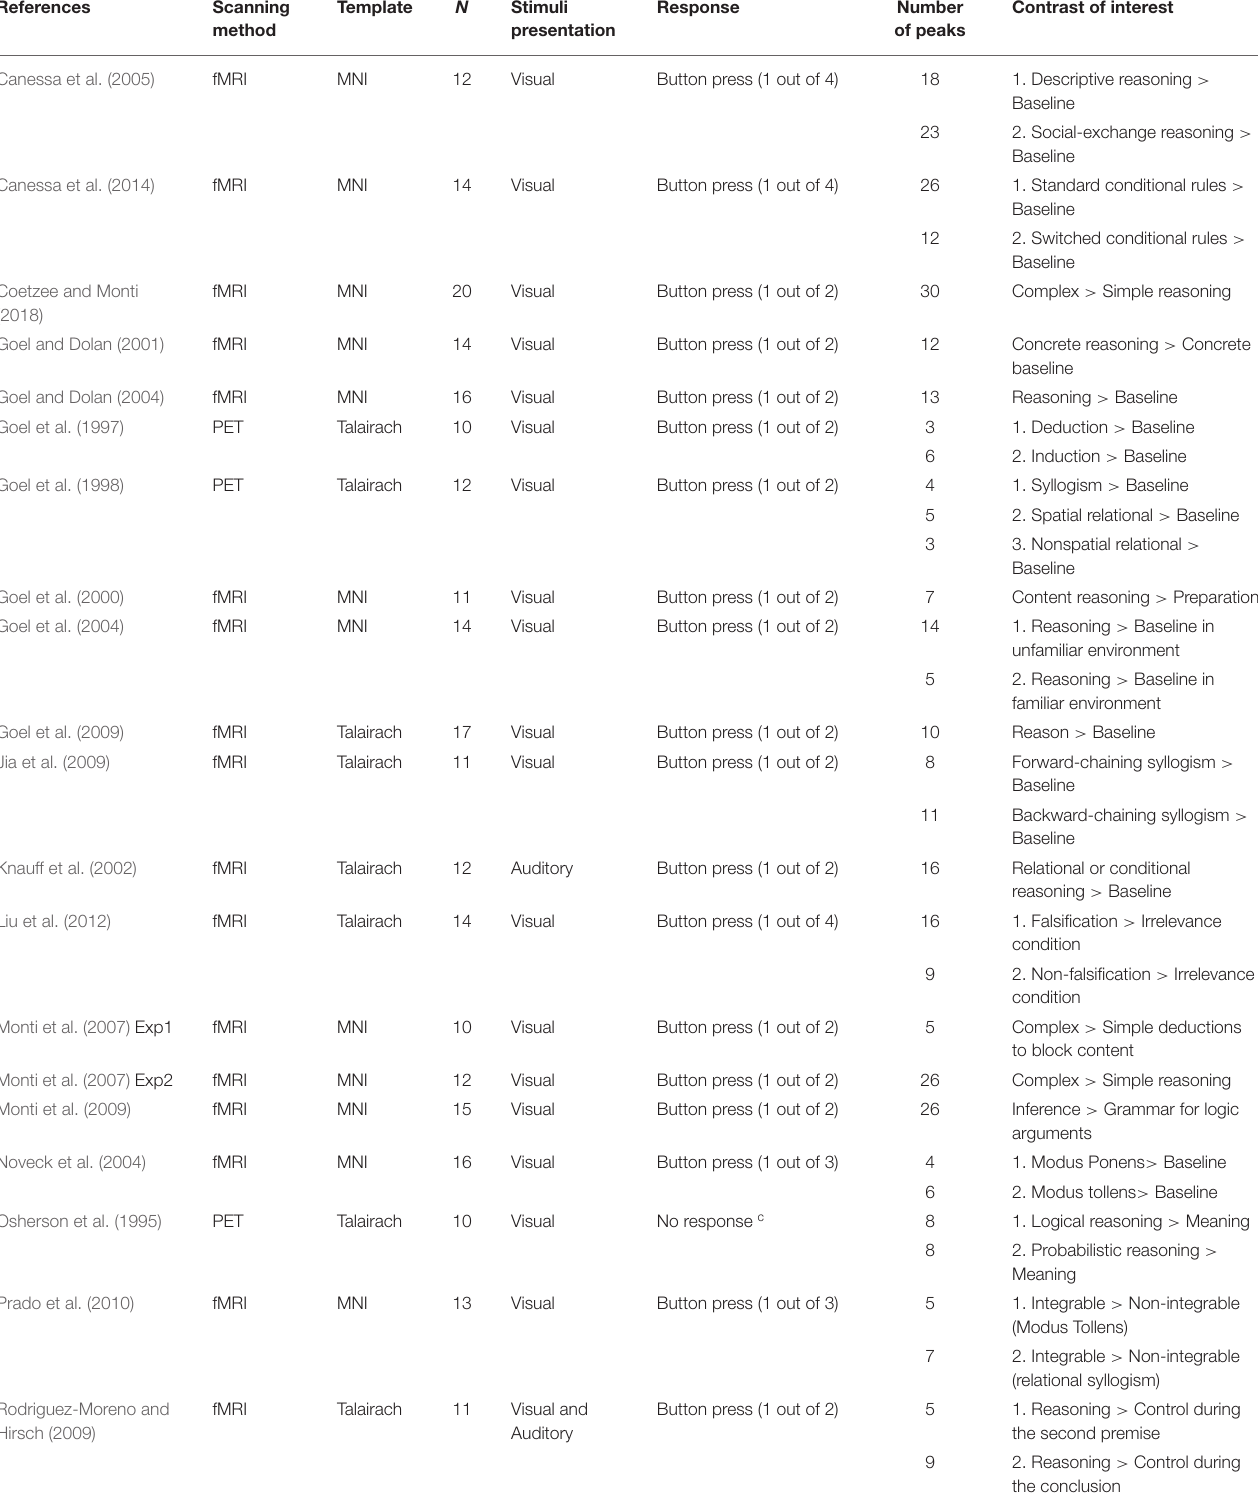
TABLE 3 | Studies on the logical inferences that were included in the